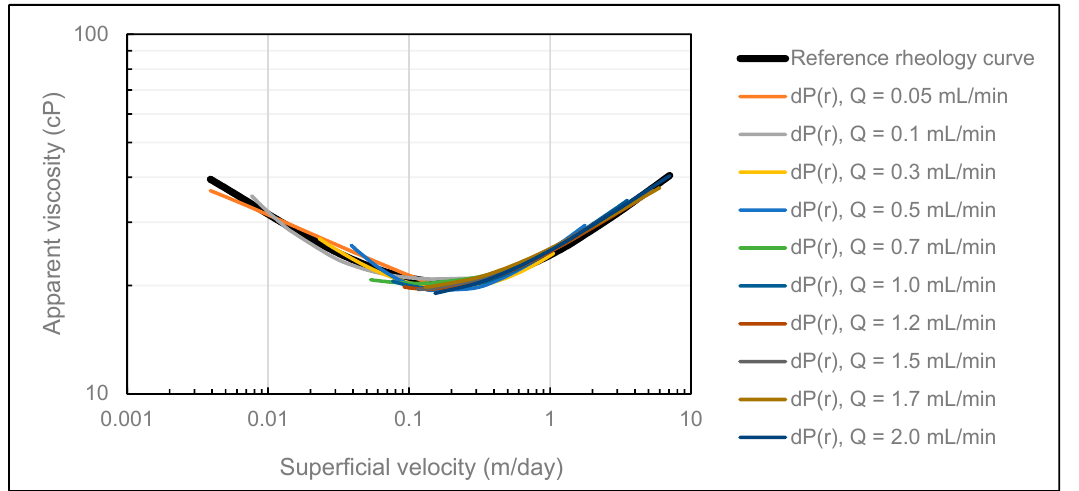
Figure 5. Comparison of the reference rheology curve (black) and rheology curves obtained in CMOST after influence of typical pressure measurement error using the DMM. Polymers 2020 , 12 , 452